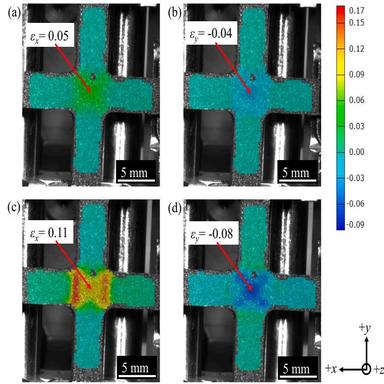
Experimental macro-strain in DP600 specimen during continuous strain path change: (a) εx and (b) εy strain distribution along uniaxial strain path before the strain path transition and (c) εx and (d) εy strain distribution after the strain path transition to biaxial strain path.